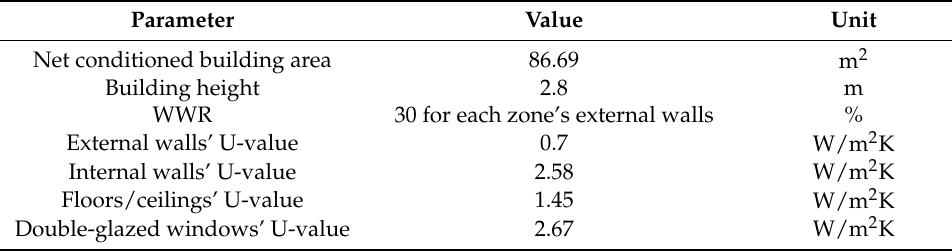
Table 3. Climatic properties of Tehran (reproduced with permission from Abbasi et al., Applied Thermal Engineering; published by Elsevier, 2018 [29]).